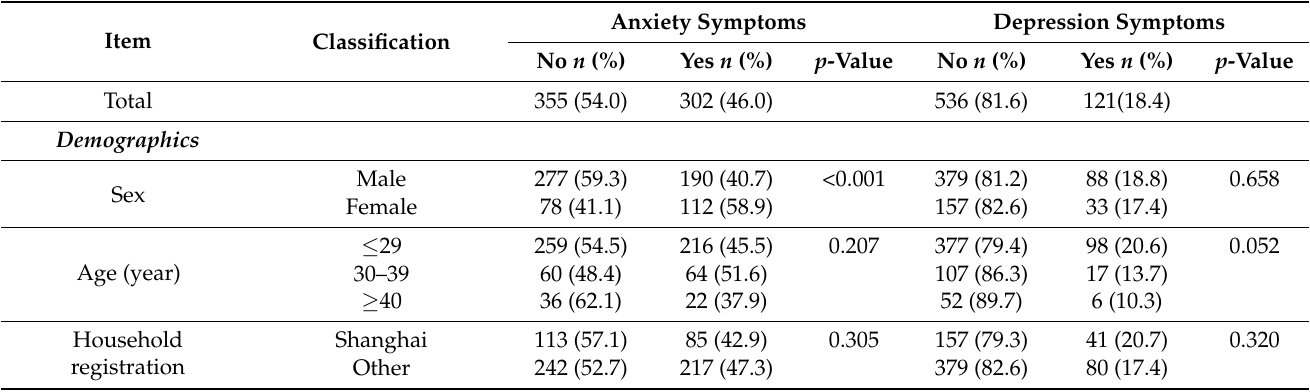
Table 2. Description of anxiety and depressive symptoms among food delivery